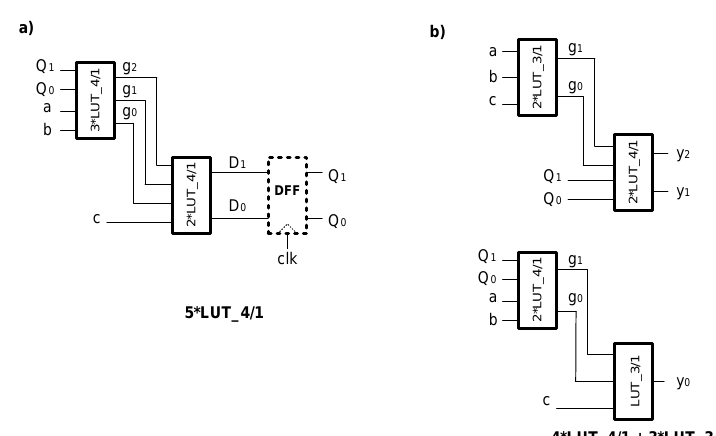
Figure 7. The result of the synthesis of FSM directed at mapping of a function into LUT_4 / 1 : ( a ) carrying out of a transition block; ( b ) carrying out of an output block.